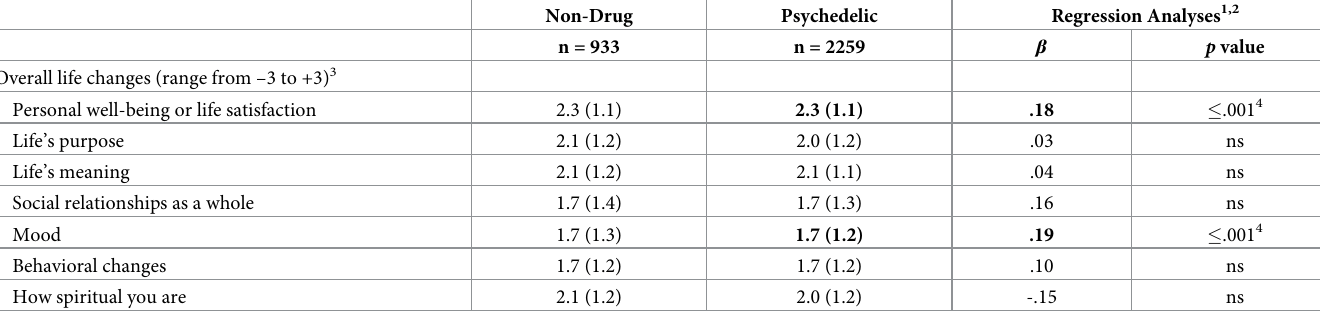
Table 11. Persisting changes attributed to the experience among the Non-Drug and Psychedelic